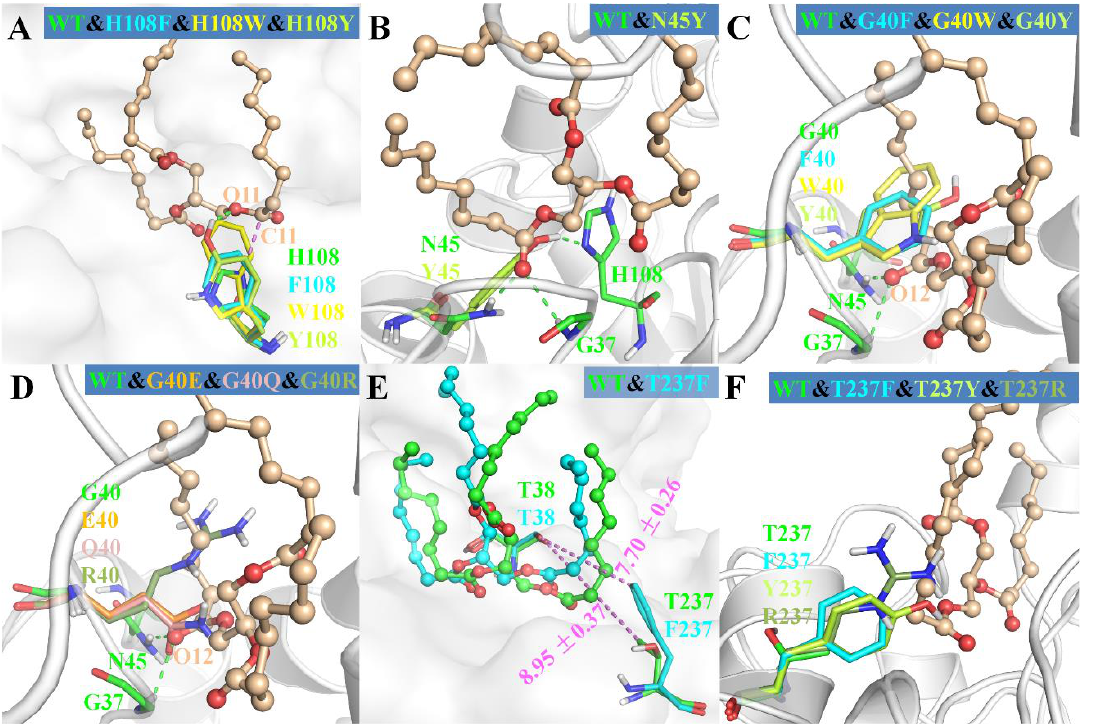
Figure 6. The structural superimposition of mutants with wild-type MAS1. The wild type was showed as cartoon or surface in each figure. The ligand from wild-type complex in wheat ball-and- stick model was showed as the reference in ( A – D , F ). In ( E ), the ligands from wild type and mutant T237F were colored in green and cyan, respectively.